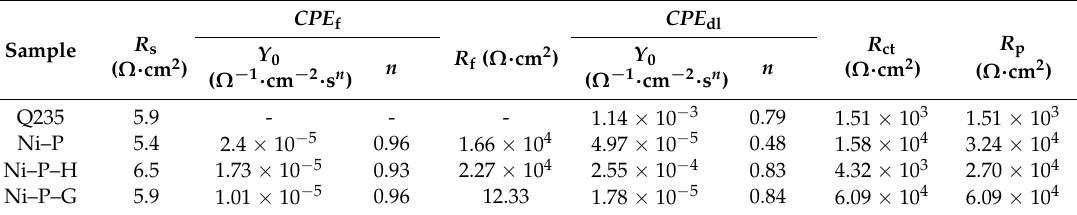
Table 1. Parameters of equivalent circuits in Figure